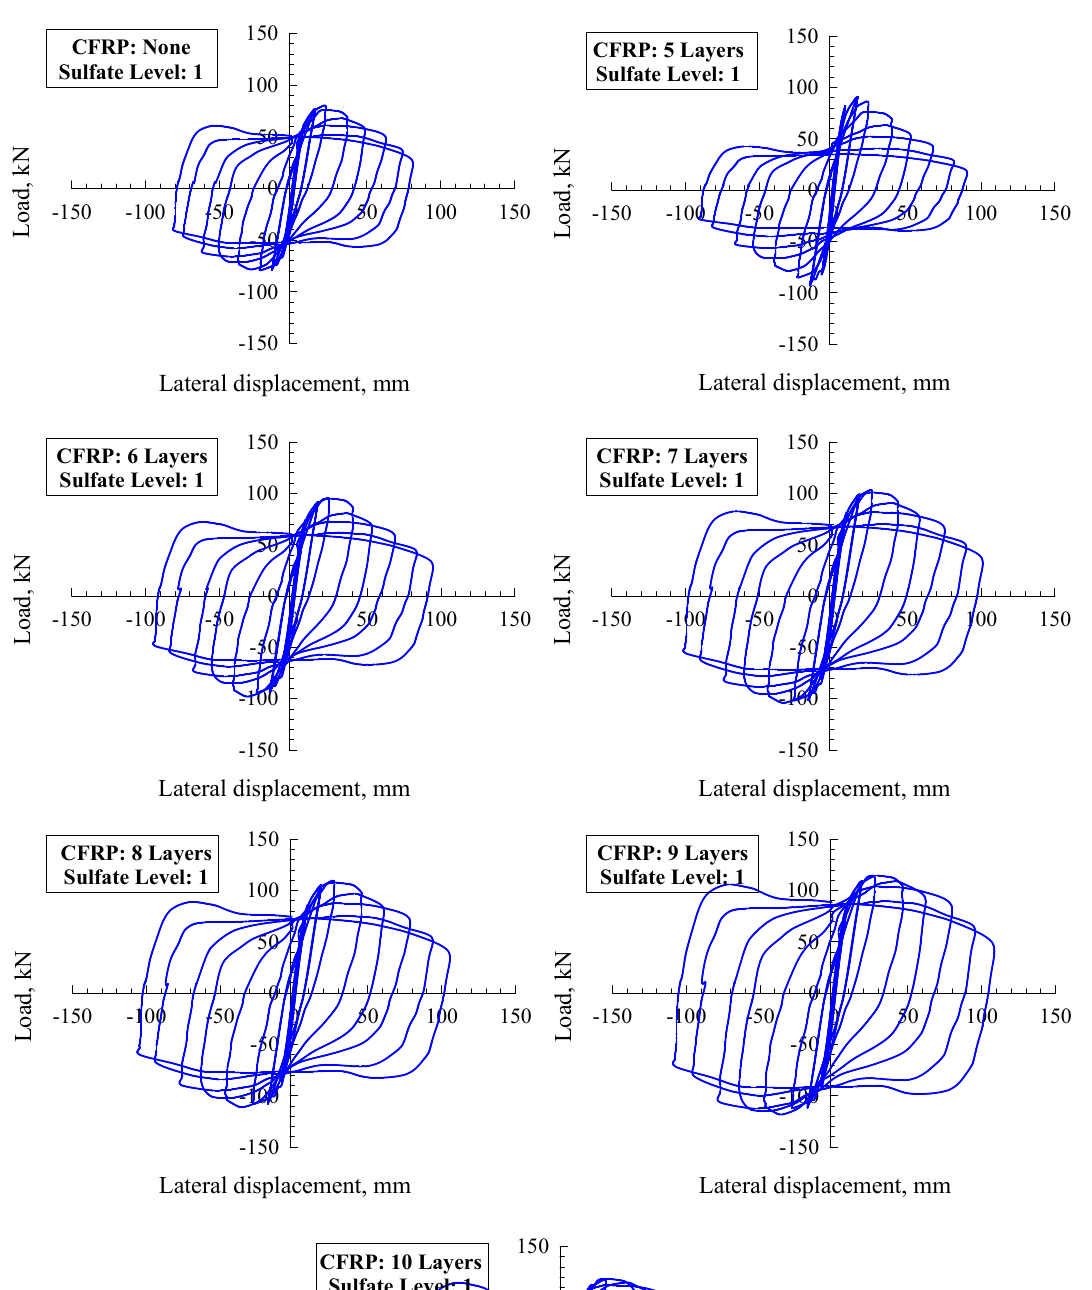
Figure 7. CFT column horizontal load–net drift hysteresis loops for sulfate level 0.